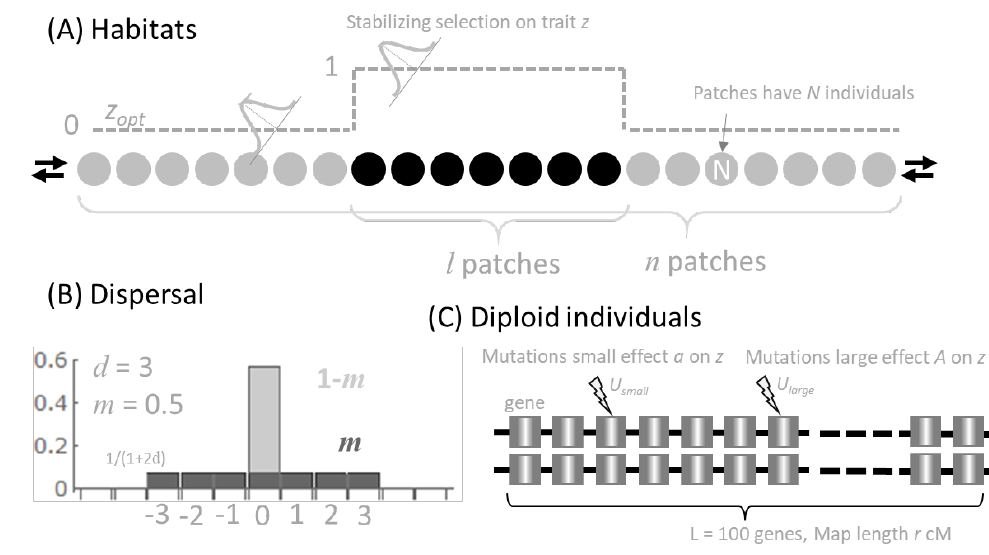
Figure 3 - Model assumptions. (A) The landscape is one-dimensional and circular with 𝑛 patches with 𝑁 individuals. Habitat 1 and 2 are made of 𝑛 − 𝑙 and 𝑙 contiguous patches with an optimal trait value 𝑧 𝑜𝑝𝑡 = 0 and 1 , respectively. Trait 𝑧 is under stabilizing selection around this optimum. (B) Dispersion kernel. A proportion 1 − 𝑚 of individuals stay in their patch, and a proportion 𝑚 is uniformly distributed among patches within distance 𝑑 of the focal patch (focal patch included). Hence, each non-focal patch receives 𝑚/(2𝑑 + 1) migrants. (C) Individuals are diploid and have a pair of chromosomes with 𝐿 loci determining trait 𝑧 . Mutation of small or large effects can occur on all these loci.